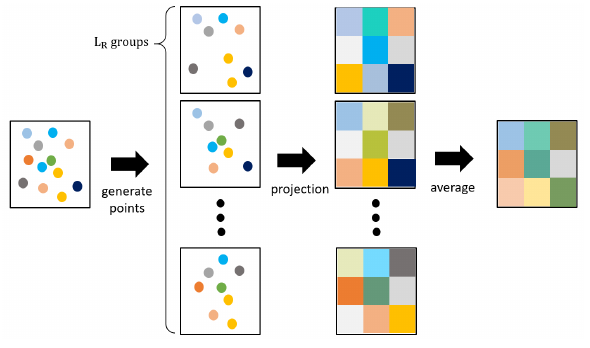
Figure 4. The stochastic point-based